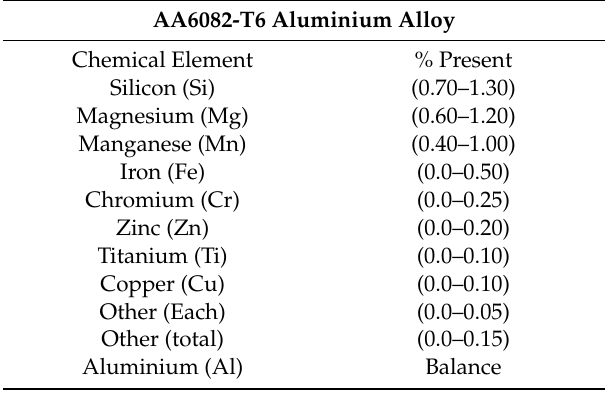
Table 1. Chemical composition of the AA6082-T6 aluminium alloy, in elemental detail